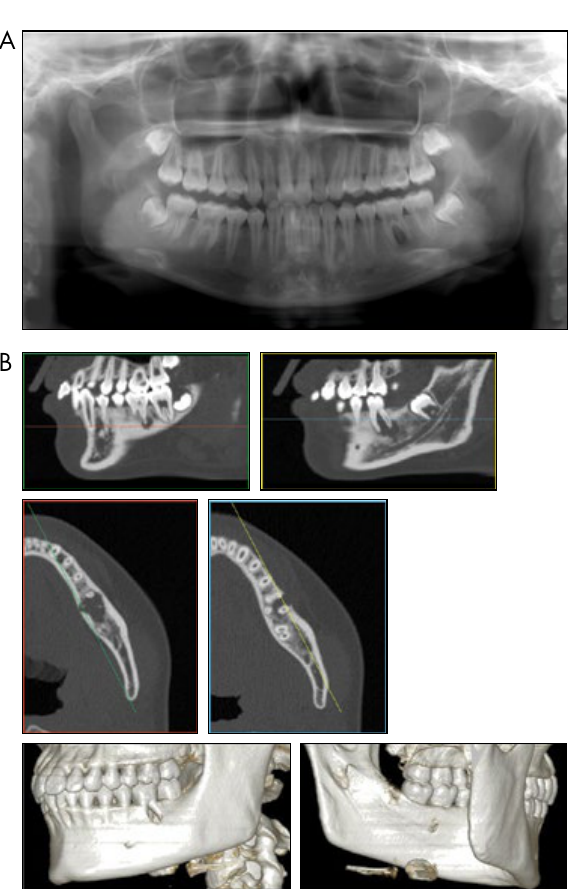
Figure 3. Pretreatment radiographs. a: Panoramic radiograph. b: Computed tomography. The colour lines and frames show the image of the corresponding cross section.